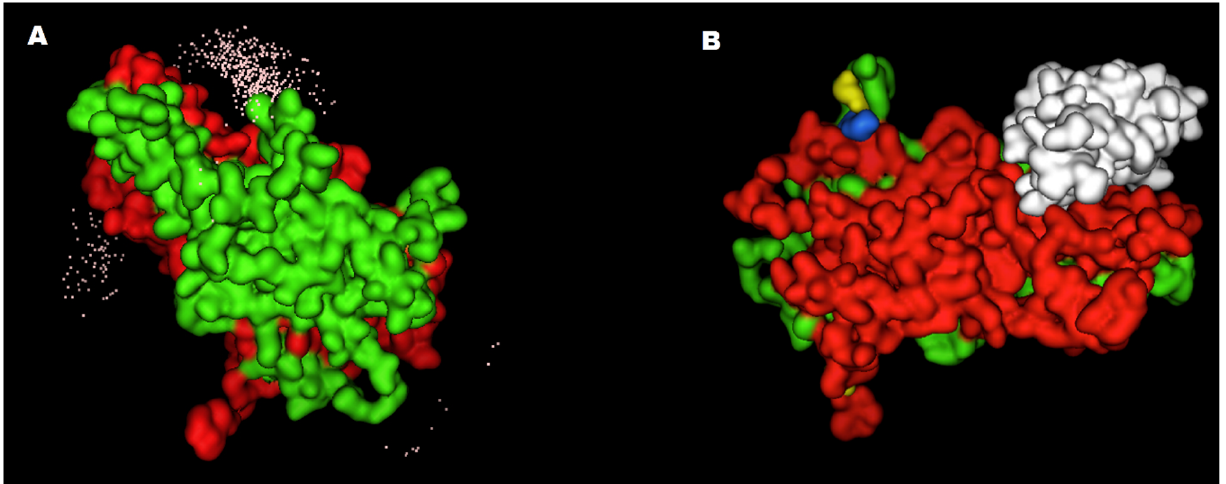
Figure 4. Lamin AC-LAP2 α docking. ( A ) White dots show the best five hundred predicted docking positions of the lamin AC binding domain on the LAP2 α Arg690Cys heterodimer surface, according to in silico assays. Each dot represents the mass center of one of the predicted positions of the lamin AC docked on LAP2 α . Dots set on the left side must be equivalent positions to those depicted on the top. However, this heterodimer shows a differential recognition preference because of the effects of the variant. ( B ) The best docking of lamin AC on the surface of the LAP2 α dimer. The wild-type LAP2 α chain is depicted in green and the 690Cys chain is depicted in red. Cysteine 690 is represented in yellow, and aspartate 538 and glutamate 539 are represented in blue. The LAP2 α recognition domain of lamin A/C is depicted in white.